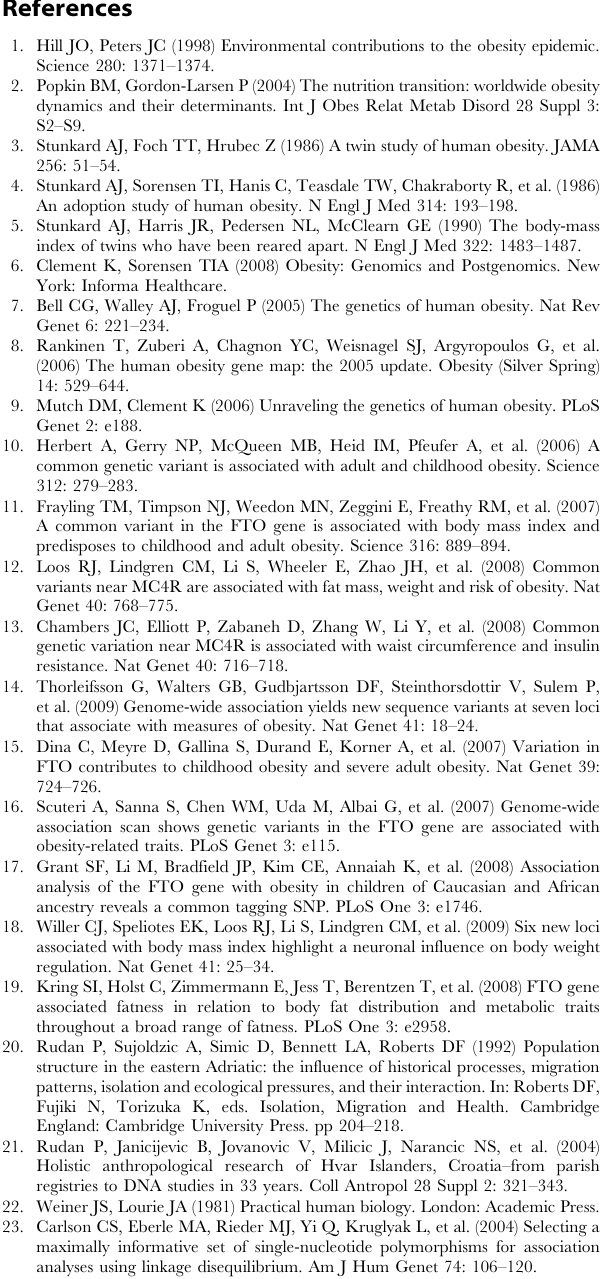
Figure S1 P values of association tests between ‘‘body fatness’’ measures (Wt, BMI, WC, HC) adjusted by PC1. Figure S2 P values of association tests between ‘‘body fatness’’ measures (Wt, BMI, WC, HC) and PC1 adjusted for